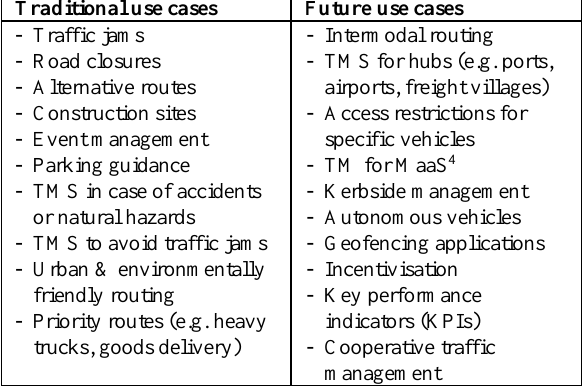
Table 1 . Traditional and future use cases of C2N